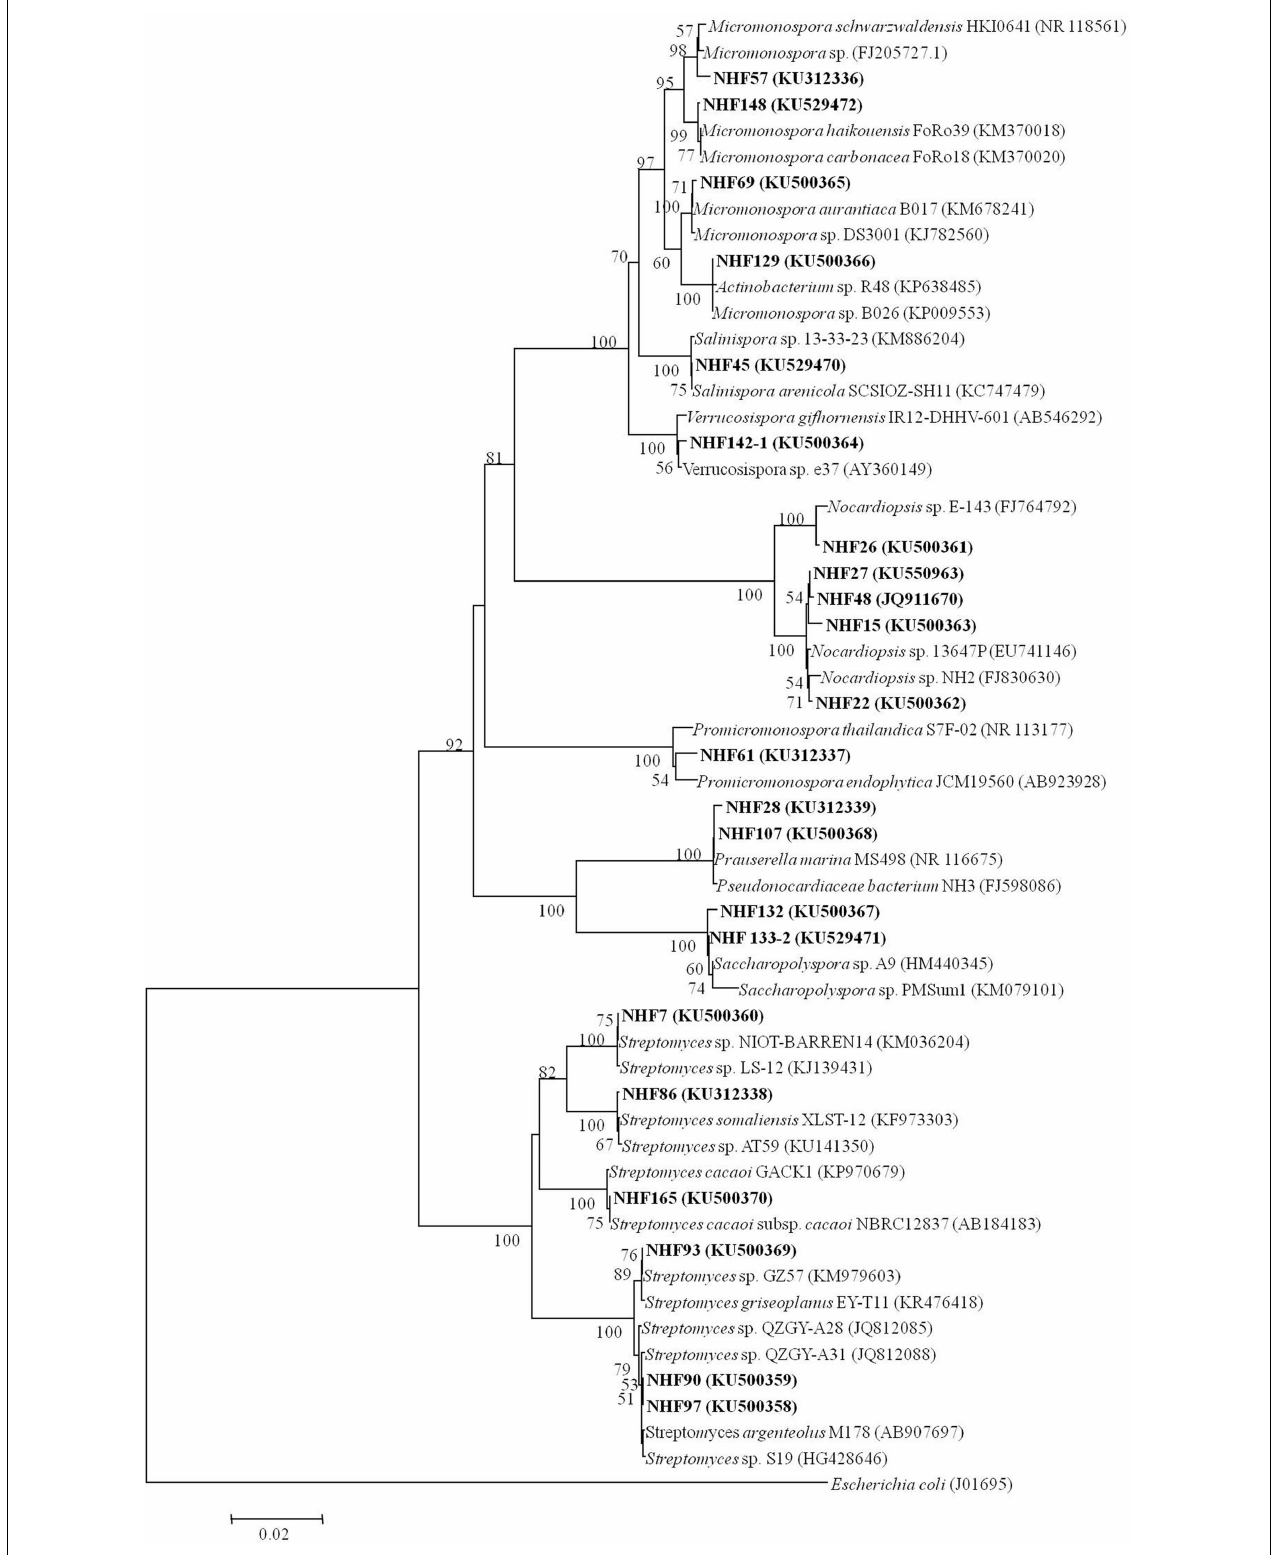
FIGURE 2 | Neighbor-joining tree showing the phylogenetic relationships of actinobacterial 16S rRNA gene sequences of obtained strains from South China Sea sediments. Bar, 0.02. Bootstrap values of > 50% (for 1000 replicates) are shown.